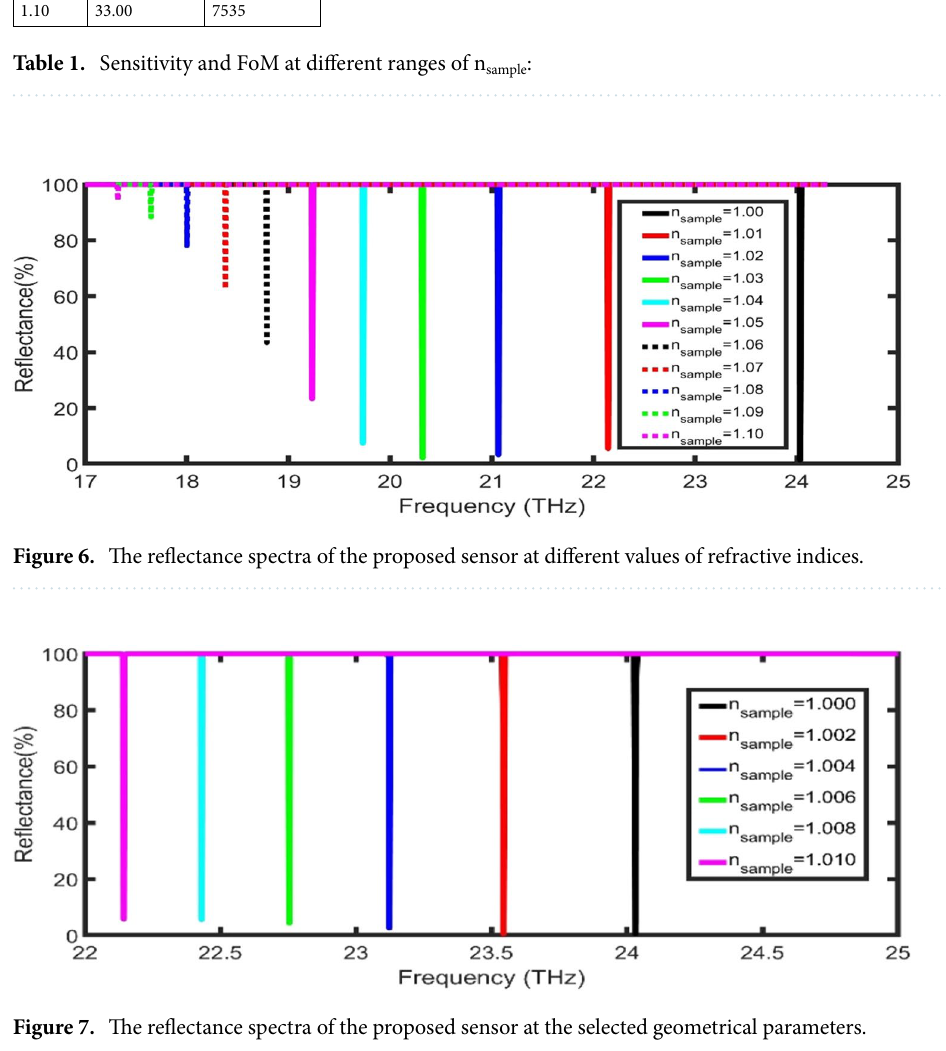
Figure 7. The reflectance spectra of the proposed sensor at the selected geometrical